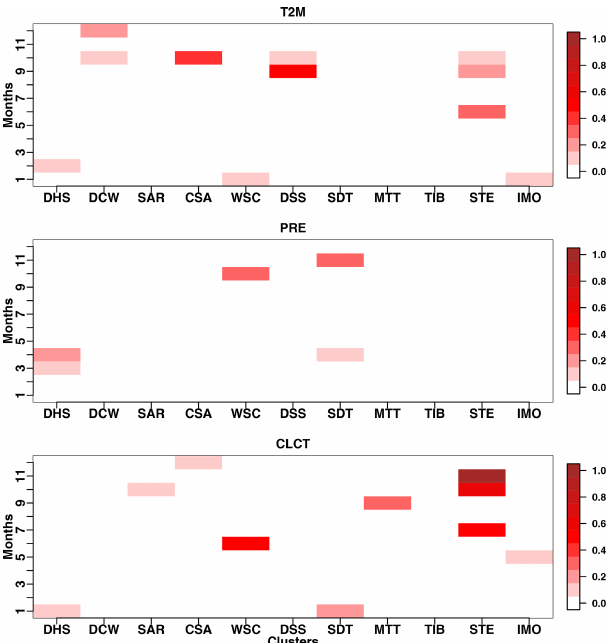
Figure 9. Effects of the sum of the different uncertainty sources in the calculation of PI for each cluster and considered month, with respect to the reference model bias against observations. The error terms are firstly divided by the bias of the reference simulation for each subregion and month. Then, the values obtained for all vari- ables are standardized between a minimum and a maximum.